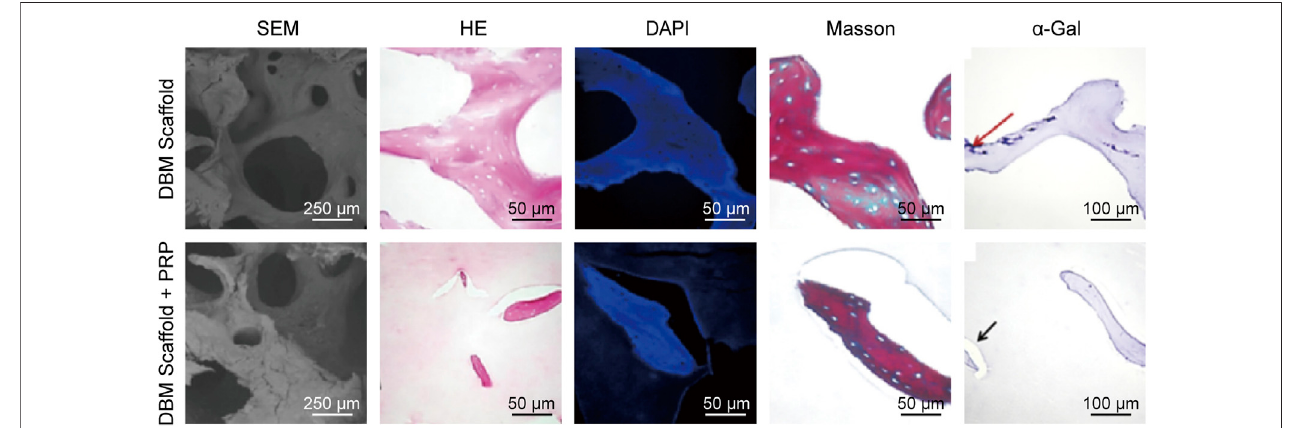
FIGURE 6 | Characterization of decellularized bone matrix scaffolds with PRP. Reproduced with permission from Leng et al. (2020).